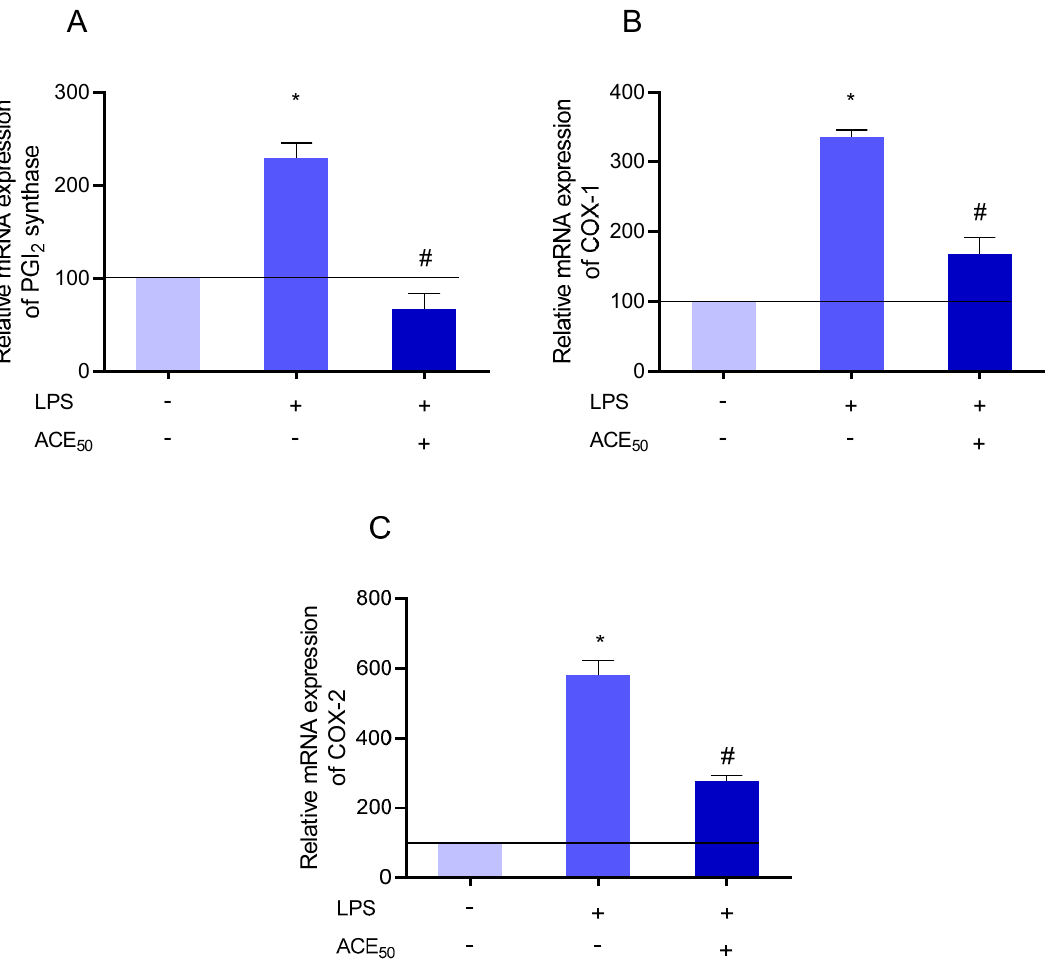
Figure 10. ( A ) The level of prostacyclin (PGI 2 ) synthase mRNA increased significantly compared to the control after LPS-treatment indicated by *. # indicates the significant changes in PGI 2 synthase mRNA in LPS-induced inflammation and ACE 50 treatment compared to the level of PGI 2 synthase mRNA in LPS-induced inflammation without ACE 50 . ( B ) The level of cyclooxygenase-1 (COX-1) mRNA increased significantly compared to the control after LPS-treatment indicated by *. # indicates the significant changes in COX-1 mRNA in LPS-induced inflammation and ACE 50 treatment compared to the level of COX-1 mRNA in LPS-induced inflammation without ACE 50 . ( C ) The level of COX-2 mRNA increased significantly compared to the control after LPS-treatment indicated by *. # indicates the significant changes in COX-2 mRNA in LPS-induced inflammation and ACE 50 treatment compared to the level of COX-2 mRNA in LPS-induced inflammation without ACE 50 . Results are expressed in the percentage of the control (100% is represented by the solid lines). Data are expressed as the mean ± SEM of four individual experiments. ACE 50 , 50 μ g/mL anthocyanin